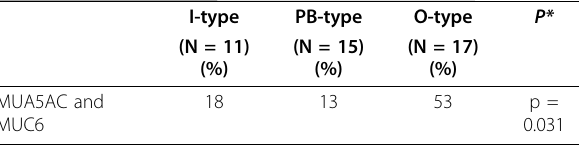
Table 7 Correlation of MUC5AC and MUC6 Coexpression with Immunohistochemical Classification